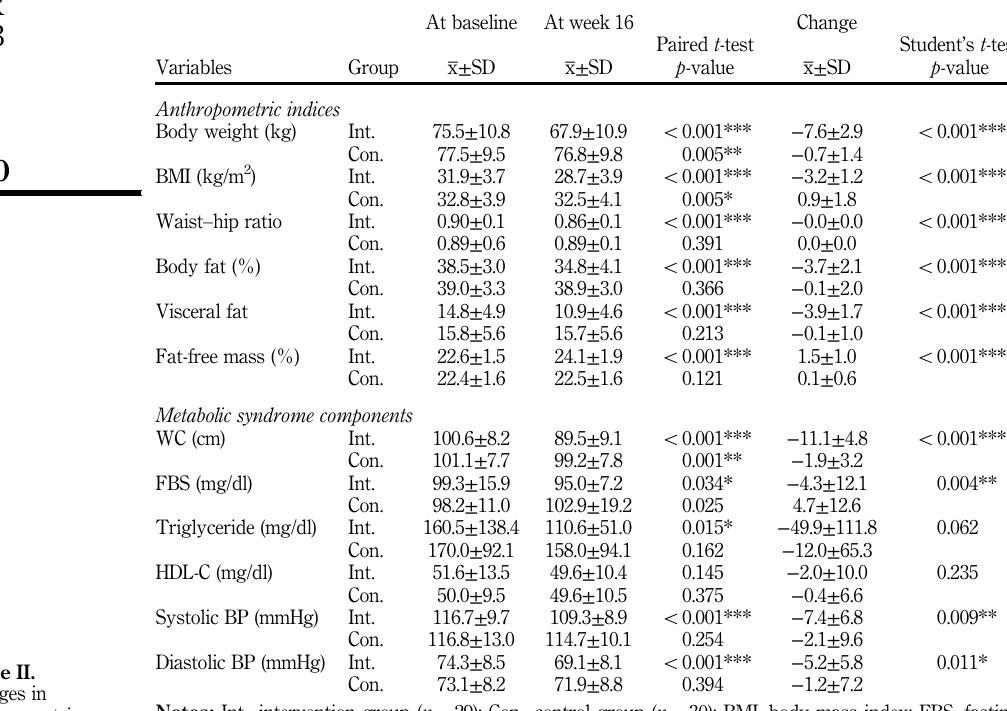
Table II. Changes in anthropometric indices and metabolic syndrome